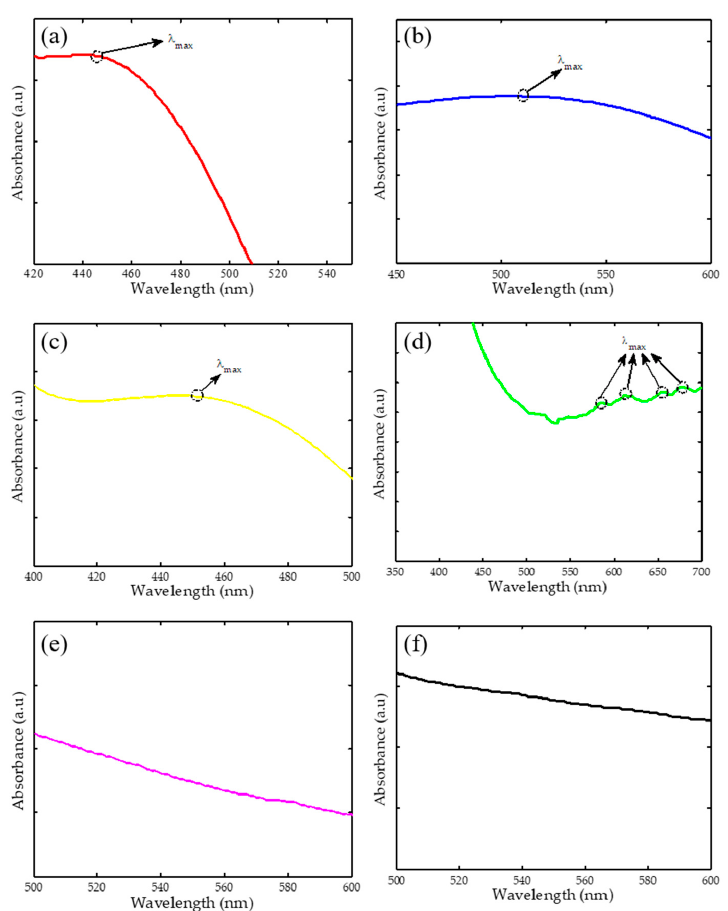
Figure 1. Ultraviolet-visible spectroscopy (UV-vis spectra) of AgNPs synthesized using different plant extracts. ( a – f ) are zoomed in portion of each spectrum.